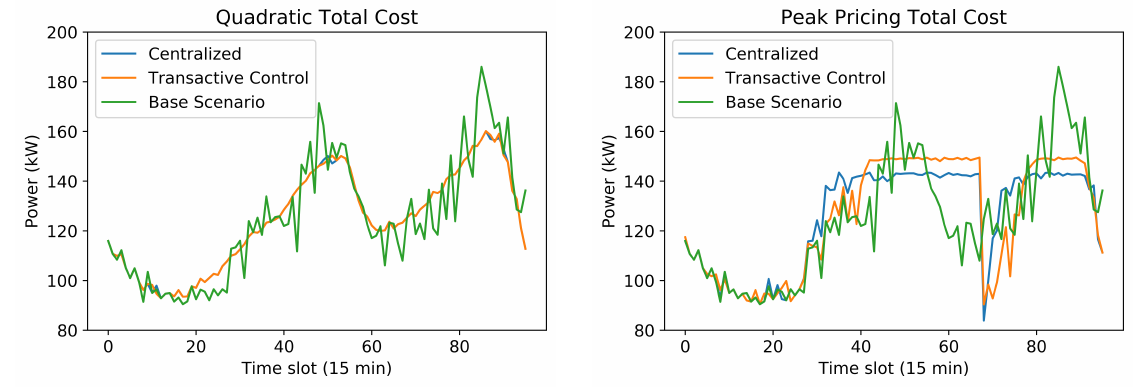
Figure 6. Final load of the community in each scenario: centralized optimization (blue), game solved with BRD (orange), and base scenario (green).